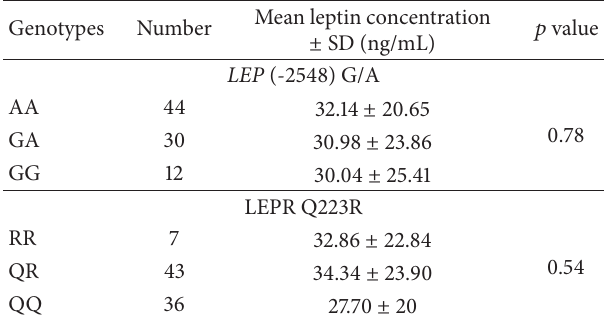
Table3:Comparisonofthemeanleptinlevelsindifferentgenotypes of -2548 G/A LEP polymorphism and Q223R LEPR polymorphism in the study population.